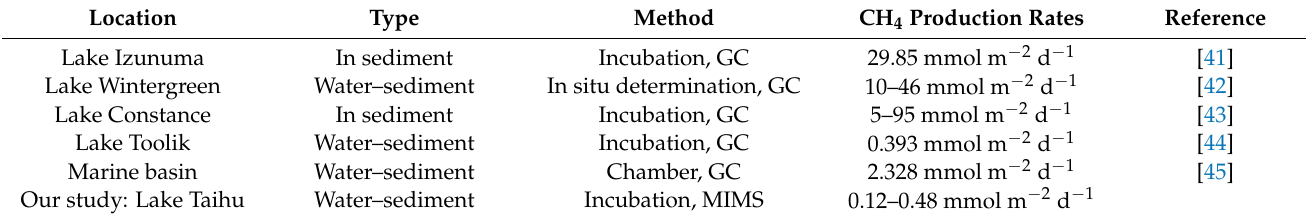
Table 3. CH 4 productions from sediments in previous